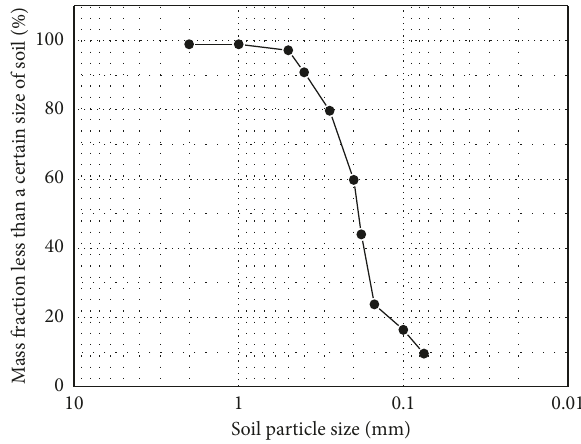
Figure 1: Grain grading accumulation